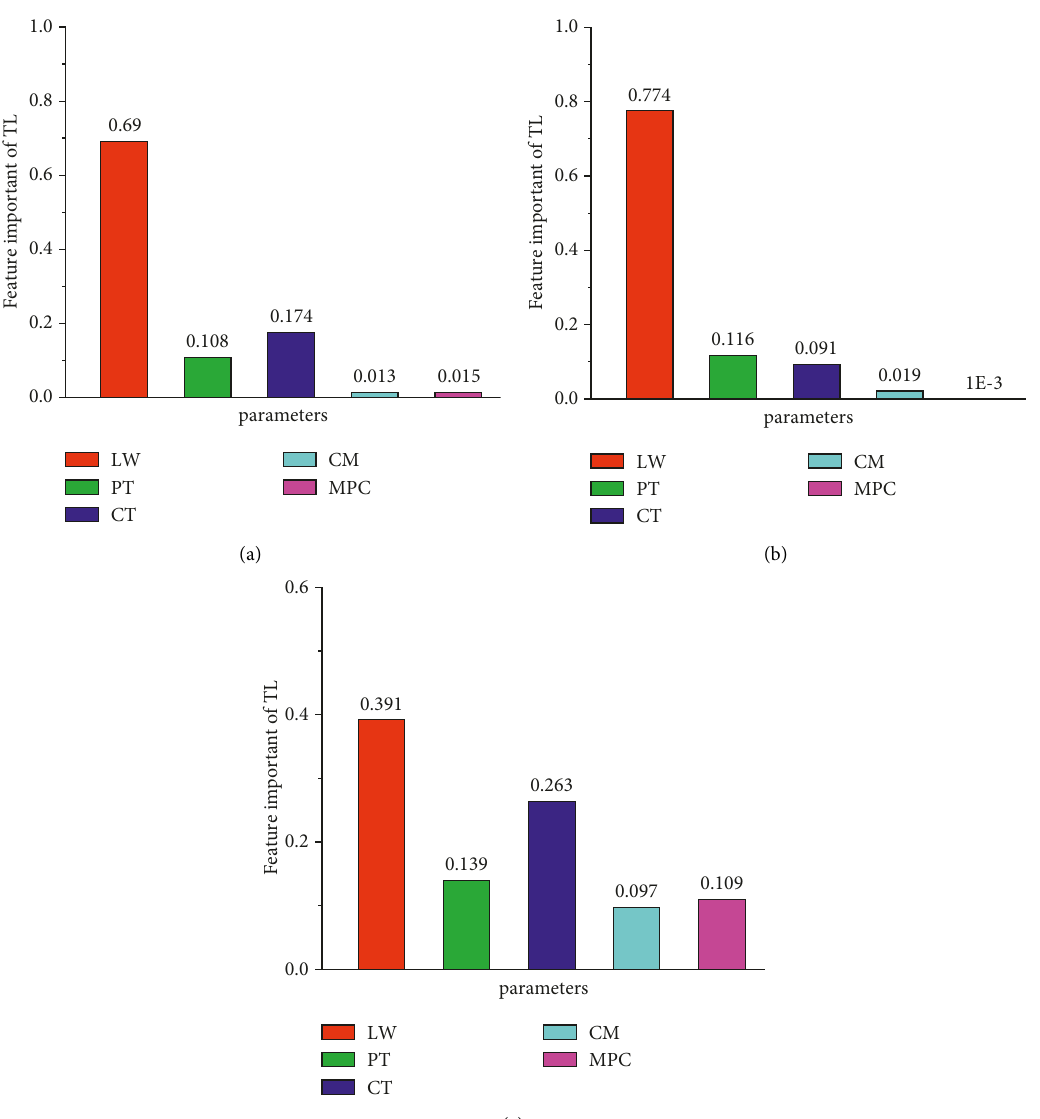
Figure 14: The weight of each parameter in the low-frequency domain of (a) 100Hz; (b) 630Hz; and (c)